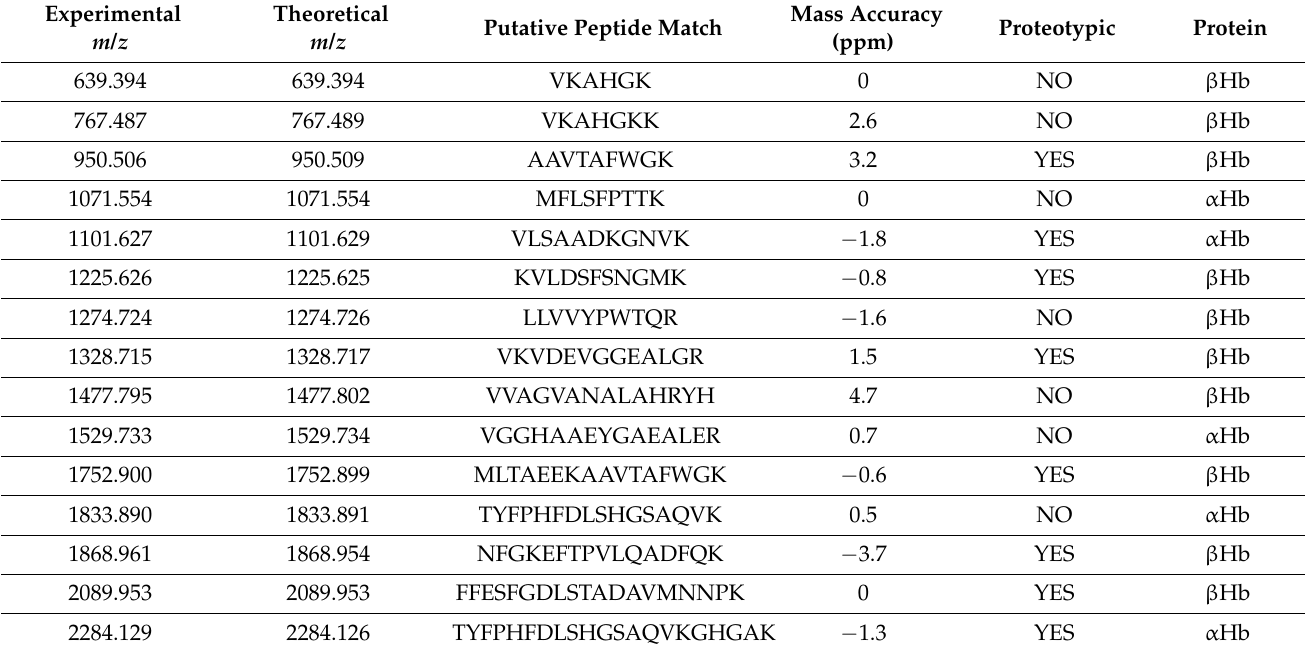
Table 1. Bovine intravenous blood peptides putatively identified with a mass accuracy ranging between − 3.7 and 4.7